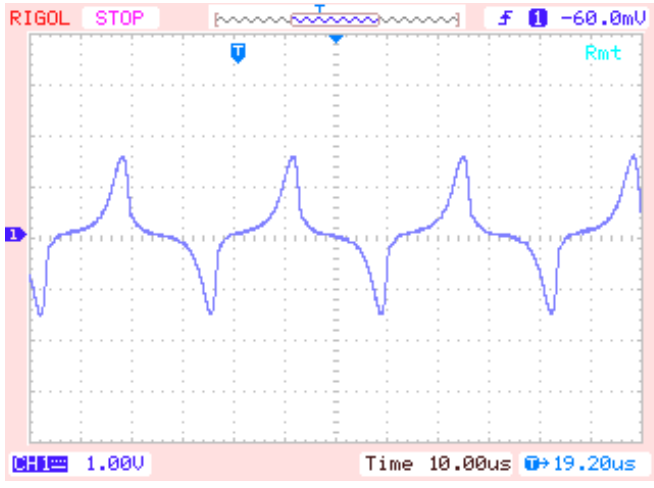
Figure 8. Output of fluxgate probe.